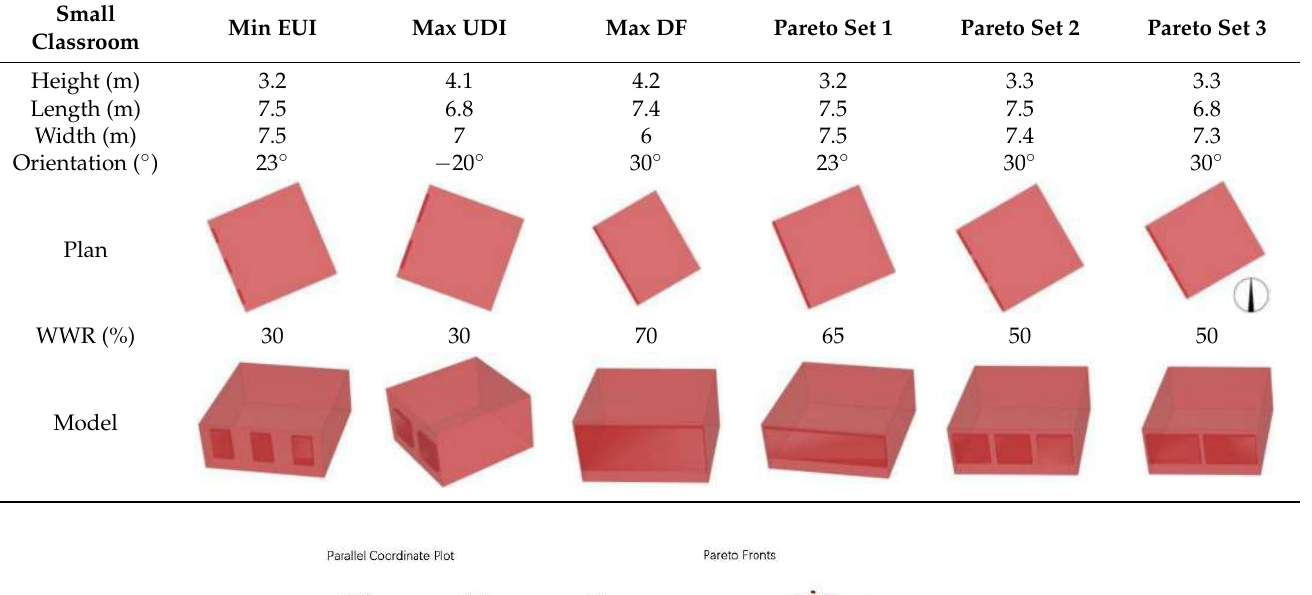
Table 8. Genomes in detail and phenotype output for small-sized classrooms with west facade fen- estration.